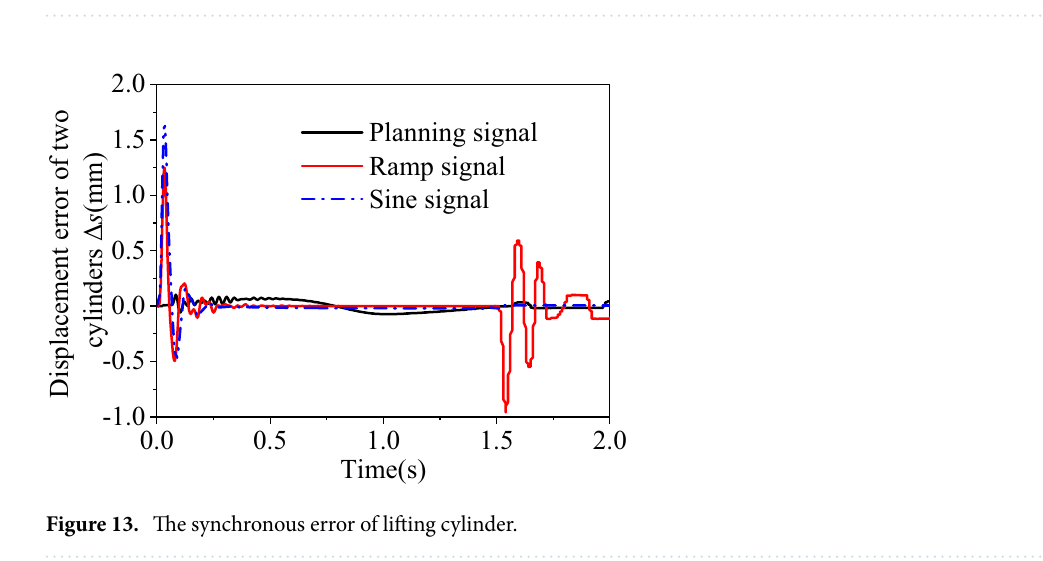
Figure 12. Moving trajectories of the lifting cylinder.